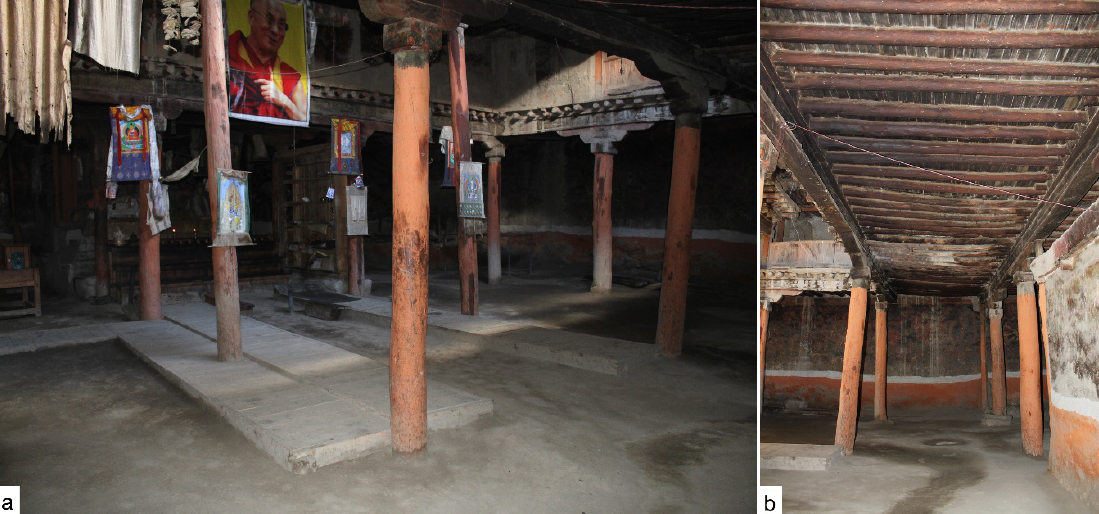
Figure 4. Gönpa Gang ground floor: ( a ) assembly hall ( dukhang ); ( b ) assembly hall—a bay between the firs and the second main beams spanning north–south.